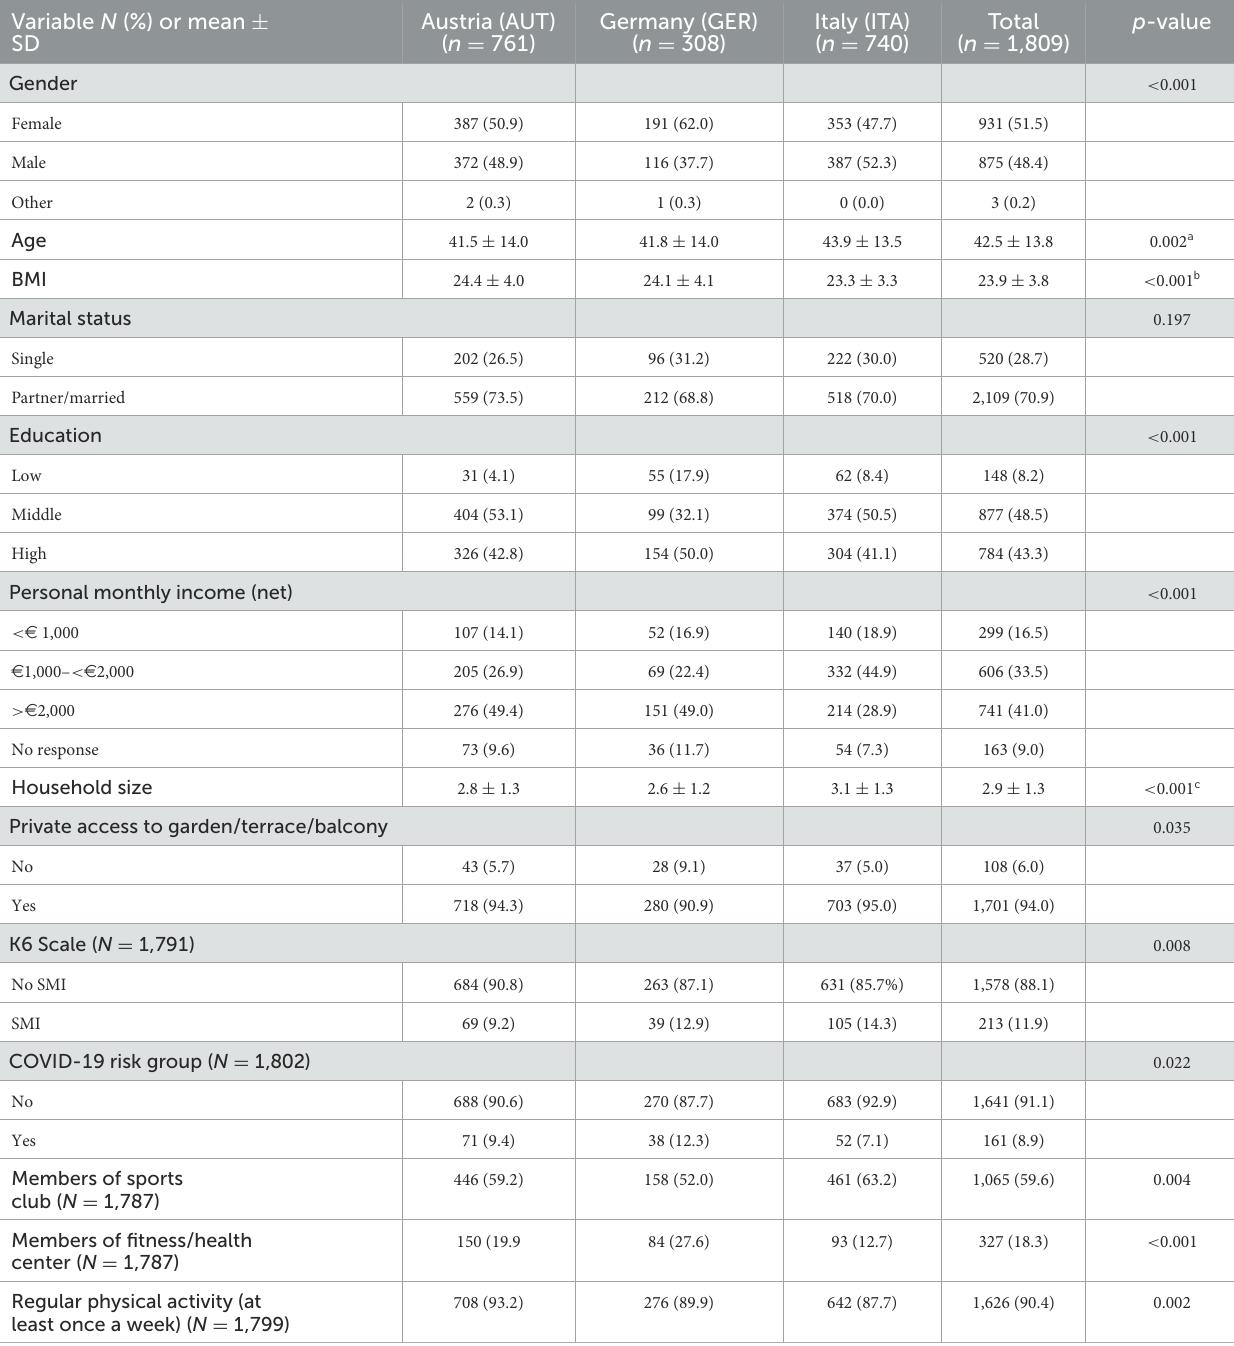
TABLE 1 Demographic and physical activity-related characteristics of participants in the Alpine regions of Austria, Germany and Italy. Variable N (%) or mean ±